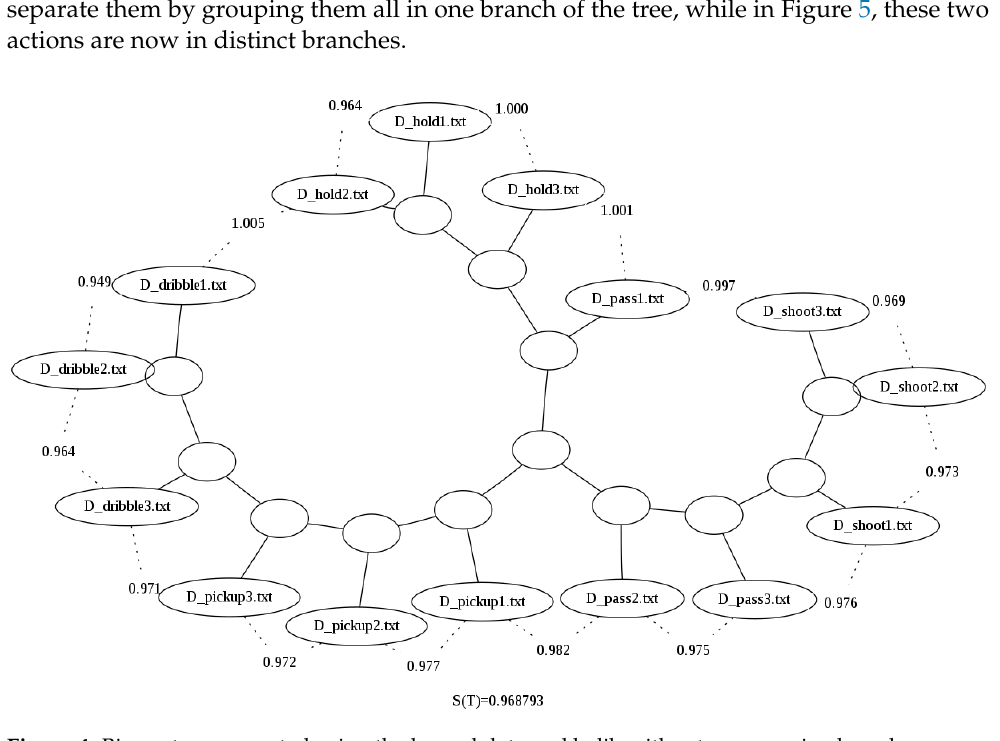
Figure 4. Binary tree generated using the looped data and bzlib without compression by column over the Basketball data set